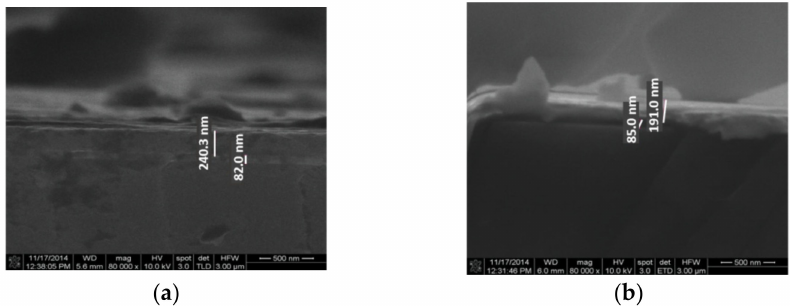
Figure 17. SEM investigations of metal films ( a ) Si/SiO 2 /Al; ( b ) Si/SiO 2 /Au. It is worth mentioning that the gold film was deposited without the adhesion layer (Cr or Ti) commonly used in order to not influence tribological measurements. Comparisons between parameters obtained with and without an adhesion layer will be made later. Another series of metals, including Ti/Au (10 nm/100 nm), Ti (100 nm), Ni (45 nm), Pt (100 nm) and Cr (150 nm), were deposited only on the silicon substrate (Figure 18).